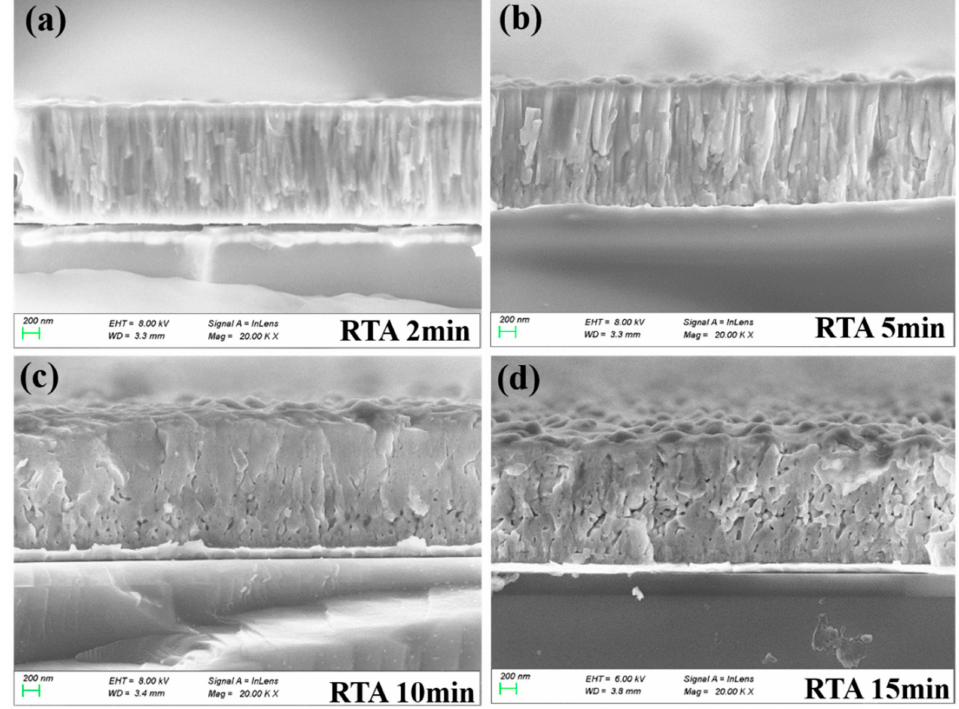
Figure 3. ( a – d ) Cross-sectional SEM images of PZT films deposited on (111) Si and annealed for 2 min, 5 min, 10 min and 15 min via a rapid thermal annealing